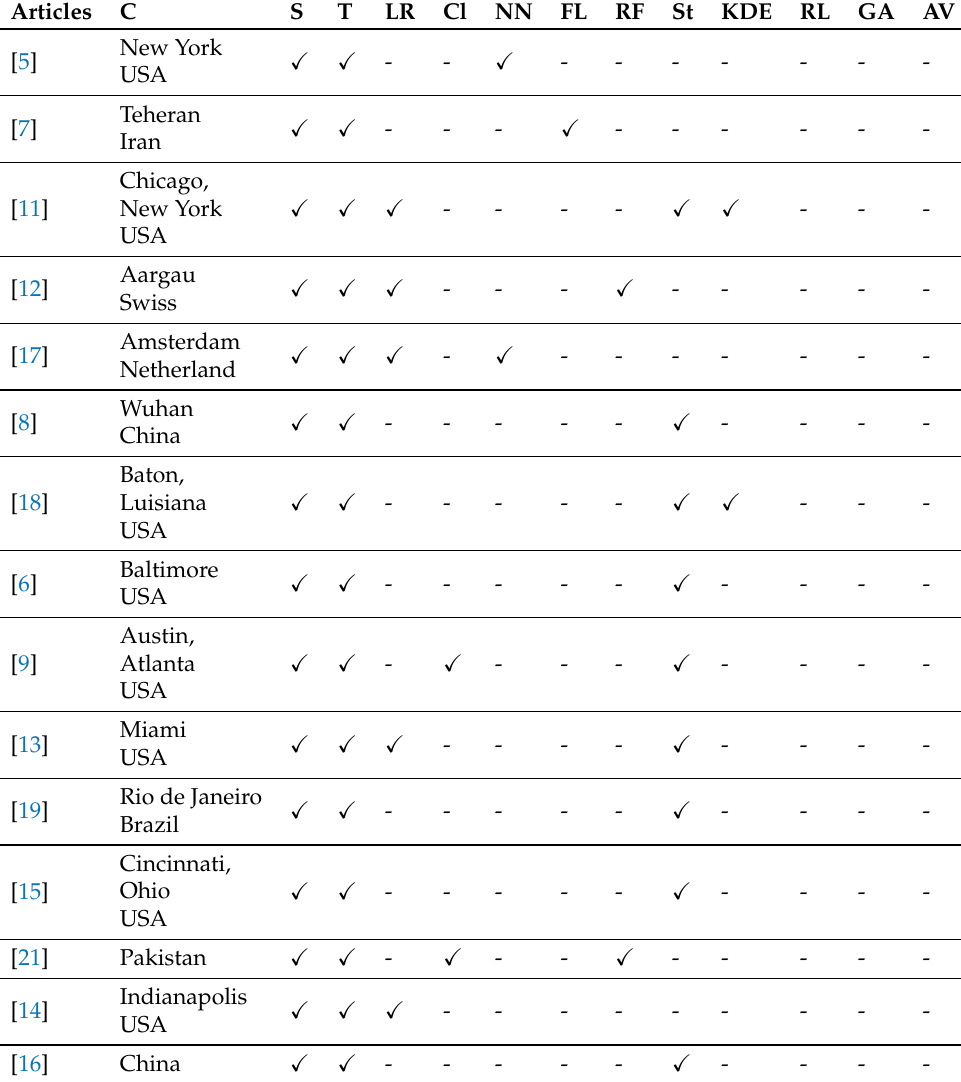
Table 1. Articles on crime prediction classified according to data information and applied